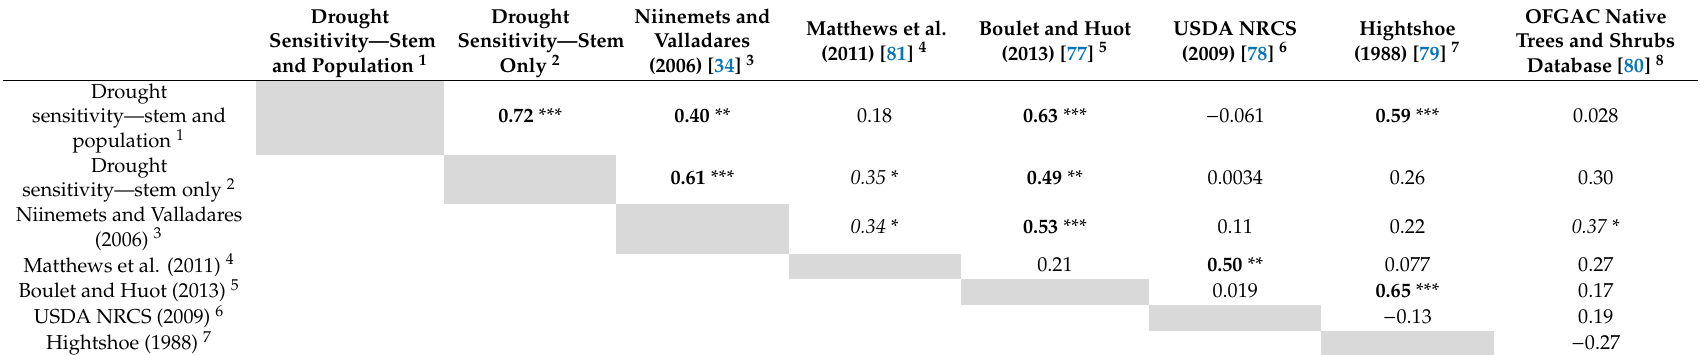
Table 1. Spearman correlations between the drought indices developed in this paper and other published indices that use various definitions of sensitivity / tolerance (definitions provided below). All indices were standardised to facilitate cross-comparisons (see Table S4). Spearman correlations between indices are indicated at